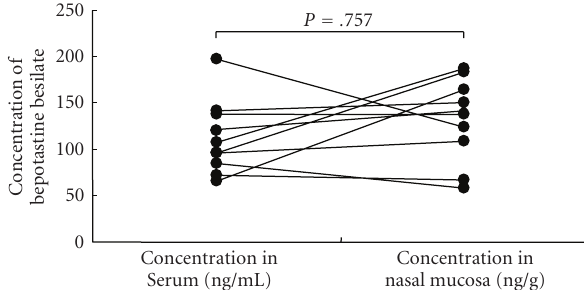
Figure 1: The graph showed the result of the concentration of bepotastine besilate in the serum and nasal mucosa of chronic rhinosinusitis with allergic rhinitis and compares using a paired t - test. Figure 3: The box plot graph showed the result of the concentration of bepotastine besilate in the nasal mucosa of chronic rhinosinusitis P = . 2662 with and without allergic rhinitis and compares using Mann- Whitney’s